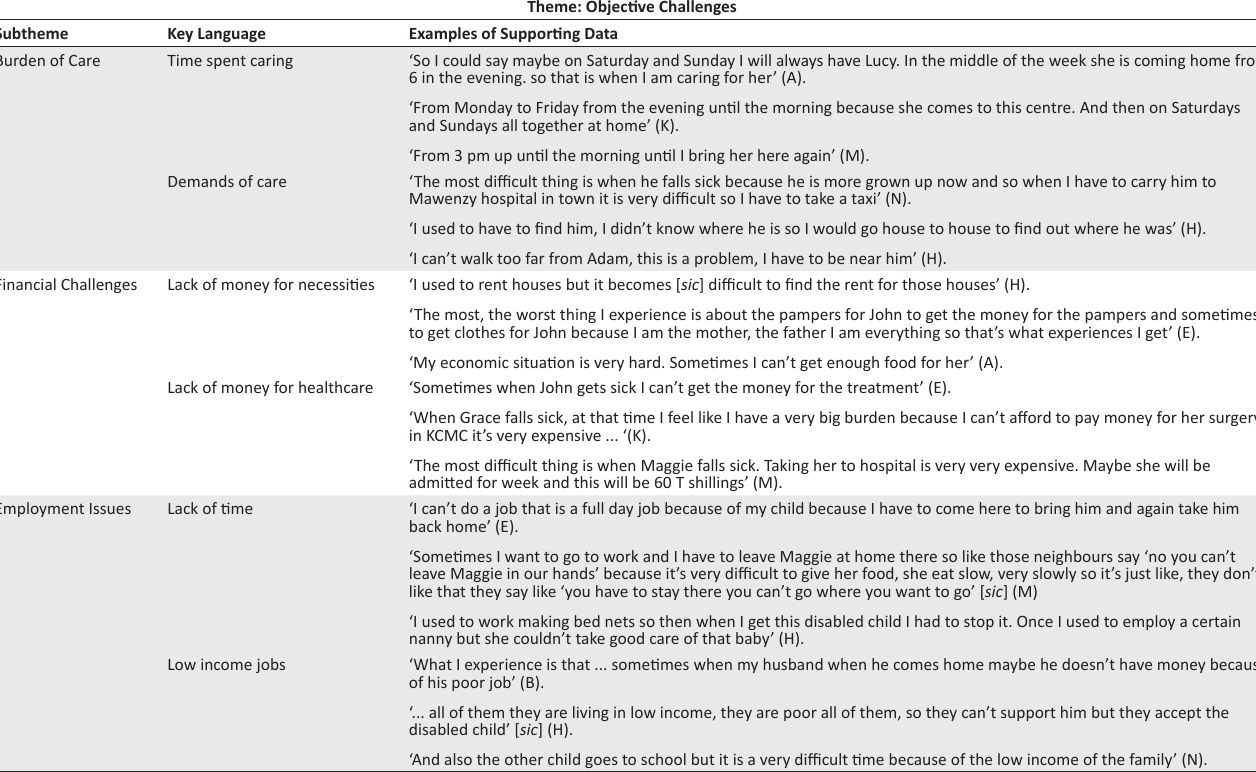
TABLE 1: The theme of objective challenges and the resulting subthemes are shown in the table